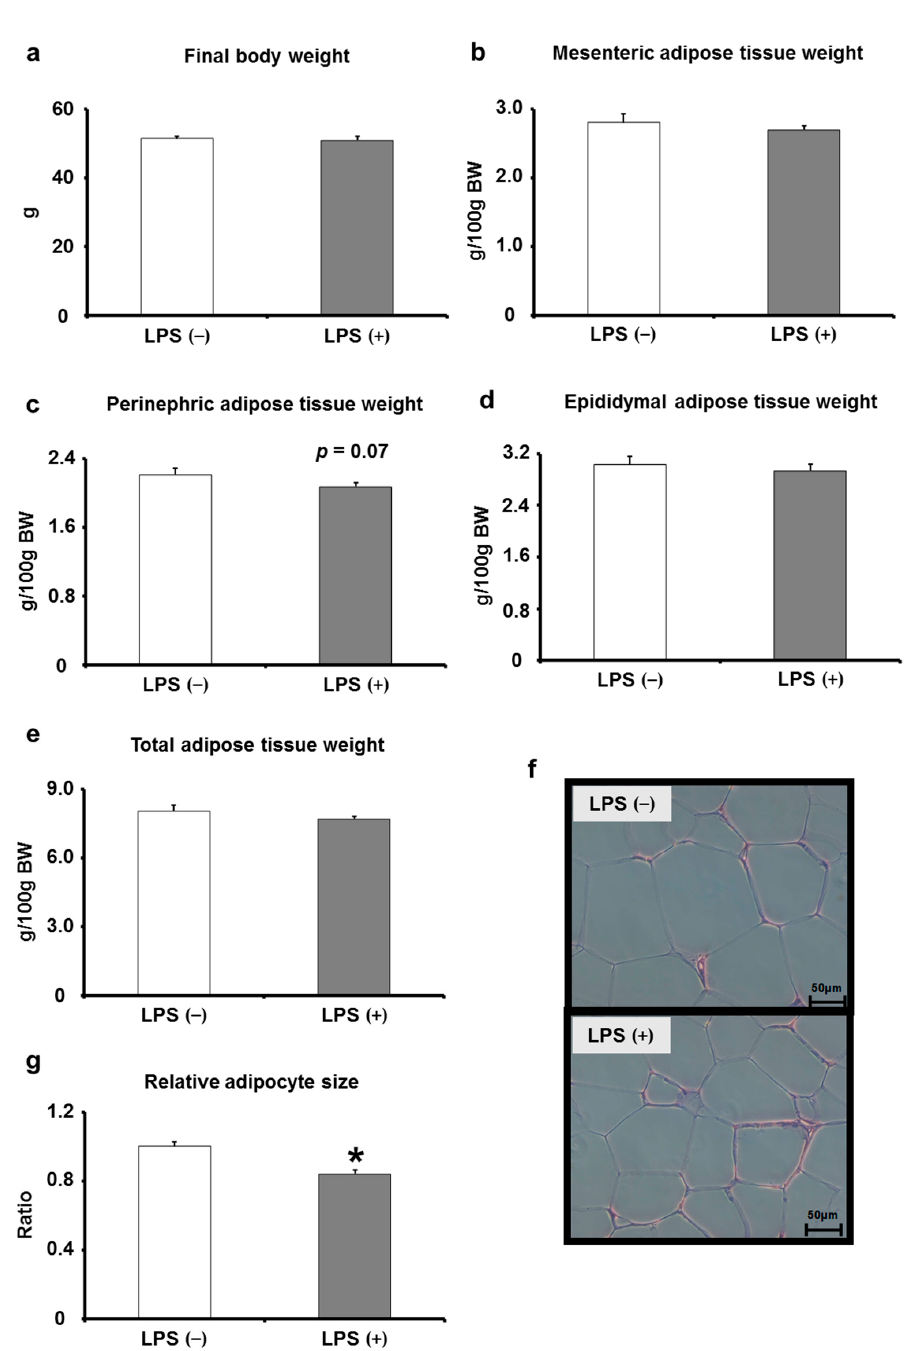
Figure 4. Effects of orally administered LPS on body weight, adipose tissue weight, and adipocyte size in KK/Ay mice. ( a – e ) The final body weight and mesenteric, perinephric, epididymal, and